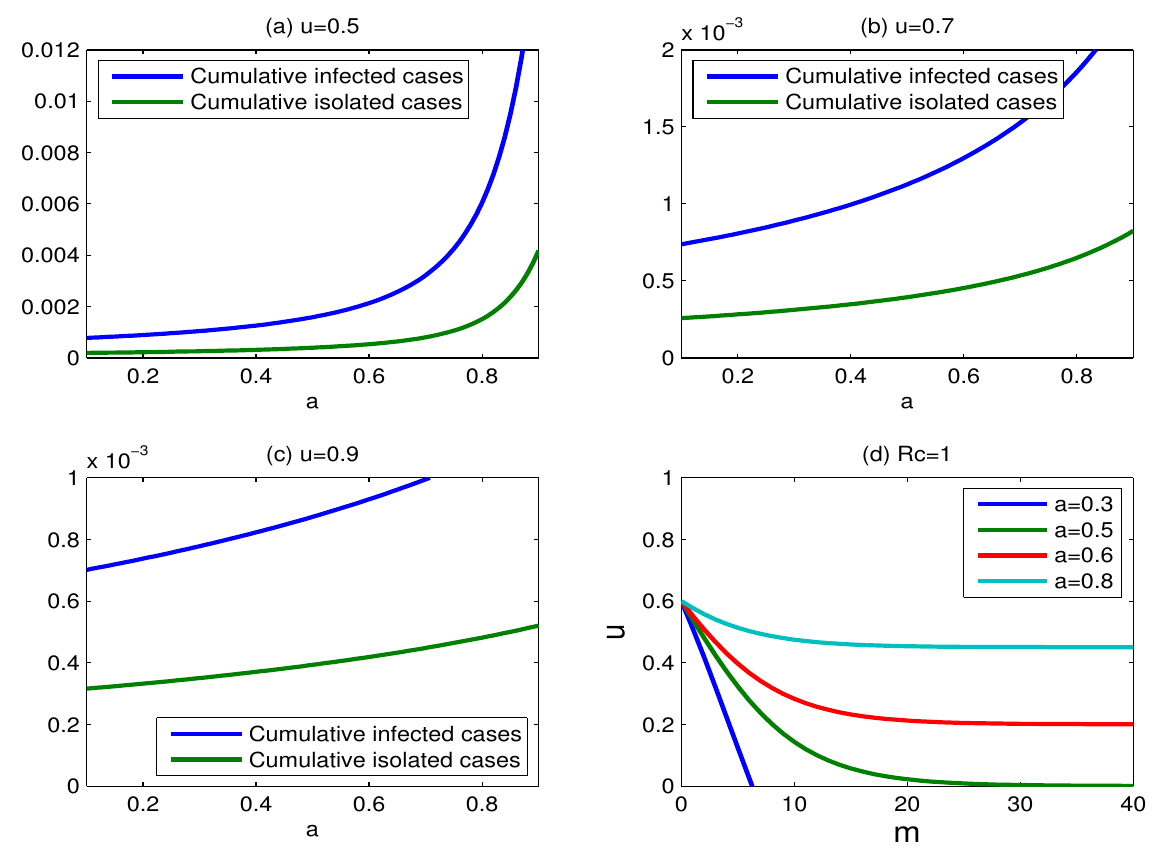
a = 0 . 3 , 0 . 5 , 0 . 6 , 0 . 8